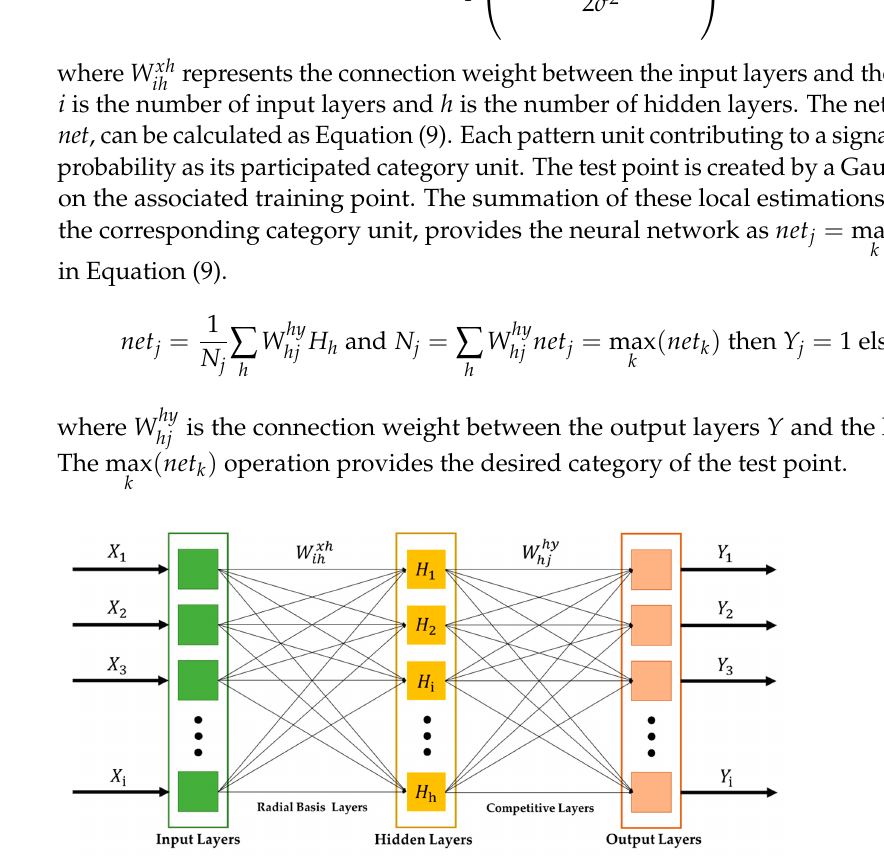
Figure 3. The architecture of